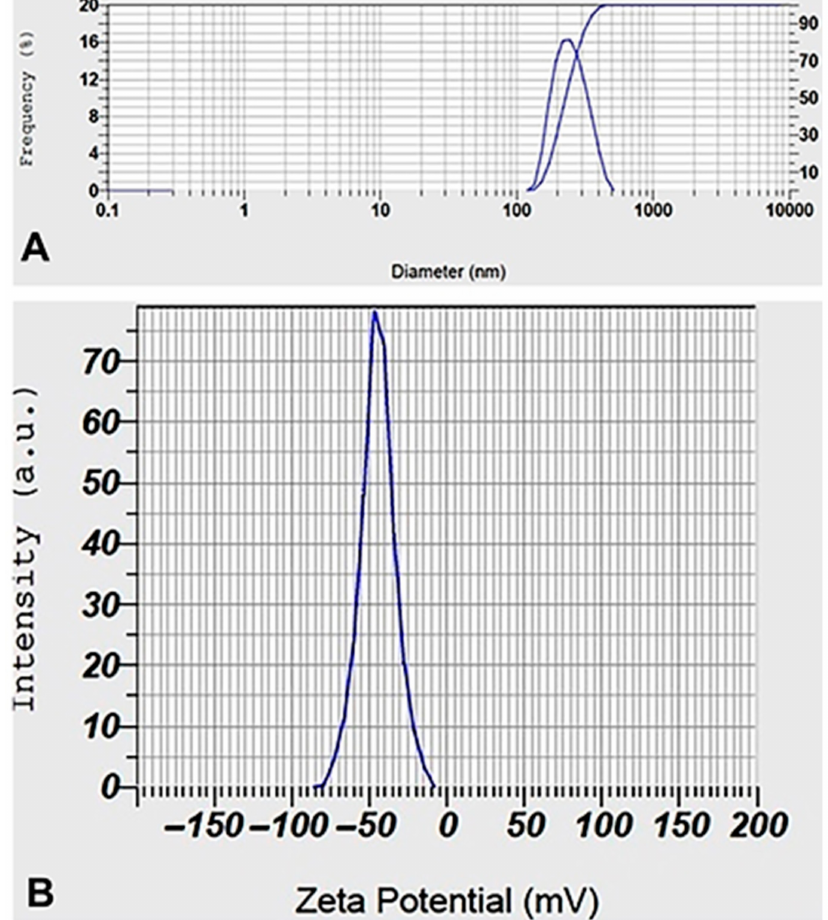
Figure 3. DLS ( A ) and Zeta potential ( B ) distribution of biosynthesized